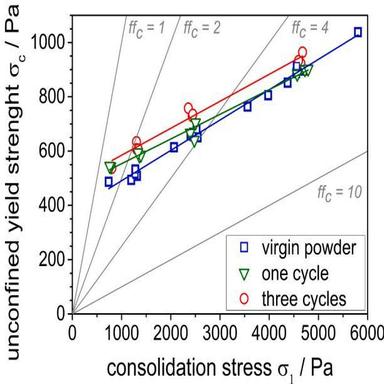
Unconfined yield strength σc in dependence on consolidation stresses σ1 for PA12 PBF powders with varying aging states. One cycle implies 15.5 h of PBF-LB/P processing at 150 ◦C building chamber temperature. Grey lines indicate similar powder flowability according to its flow function ffc.